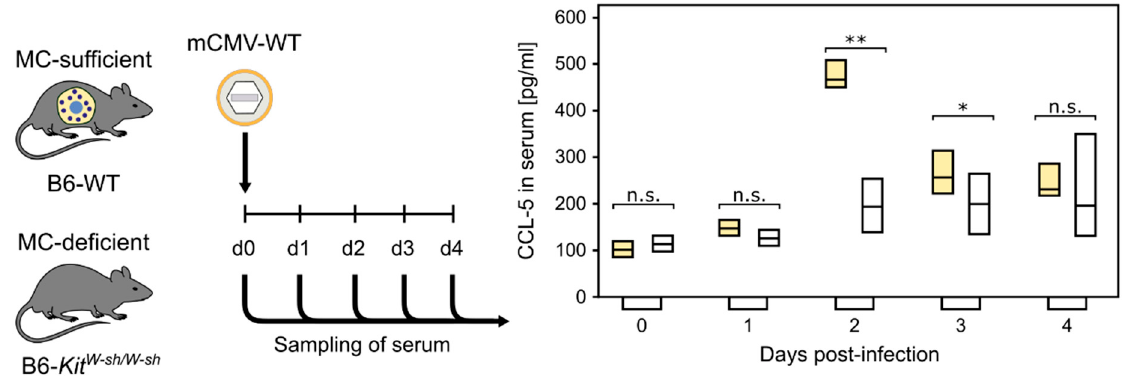
Figure 1. MC-dependent wave of serum chemokine CCL-5. (n.s.) Not significant; (*) p < 0.05; (**) p < 0.01. (Yellow bars) Presence of MC. (Open bars) Absence of MC. Bars represent the range of data from individual mice. Median values are indicated. Results are displayed schematically based on original data published in [73].